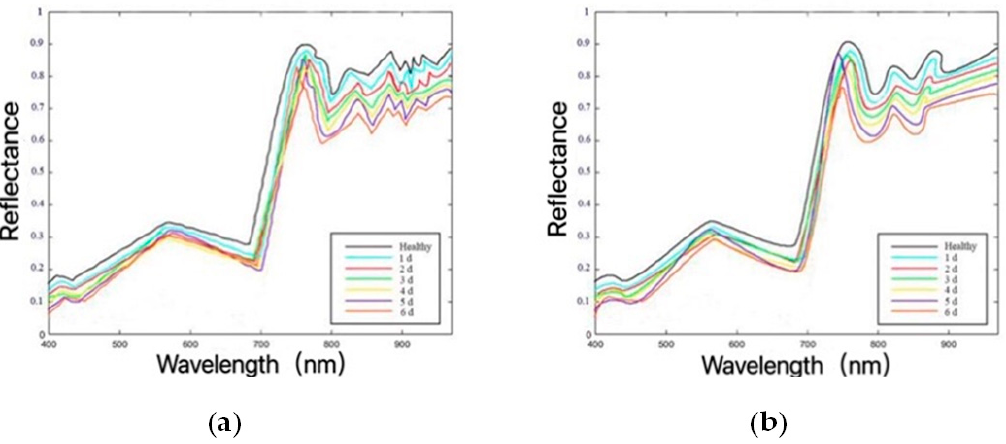
Figure 8. ( a ) Raw mean spectral of the healthy and infected samples and ( b ) mean spectral preprocessed by multiple scattering correction (MSC) + standard normal variable (SNV).